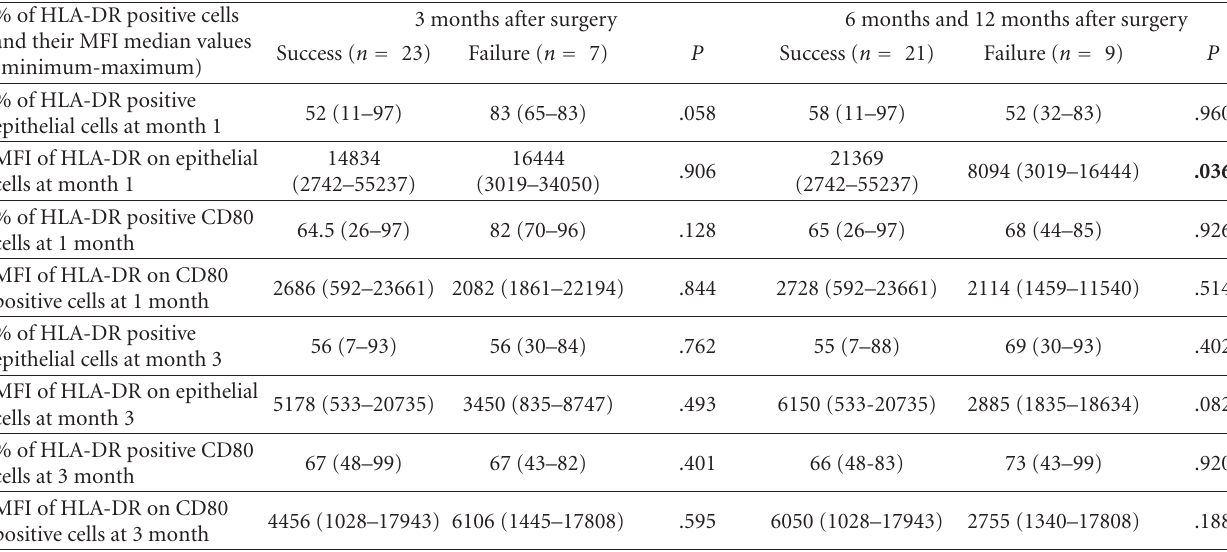
Table 2: Percentage of HLA-DR positive epithelial and CD80 positive cells (antigen-presenting cells) and mean fluorescence intensity (MFI) of ocular surface inflammatory molecules obtained by impression cytology at month 1 and 3 of follow-up in eyes with successful and failed